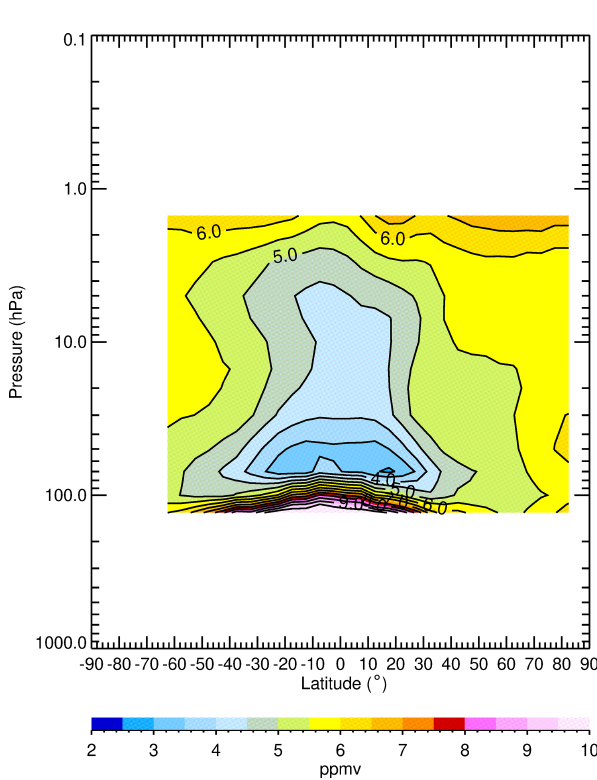
Figure 2. Zonal average temperature for March 1979. CI is 5K.